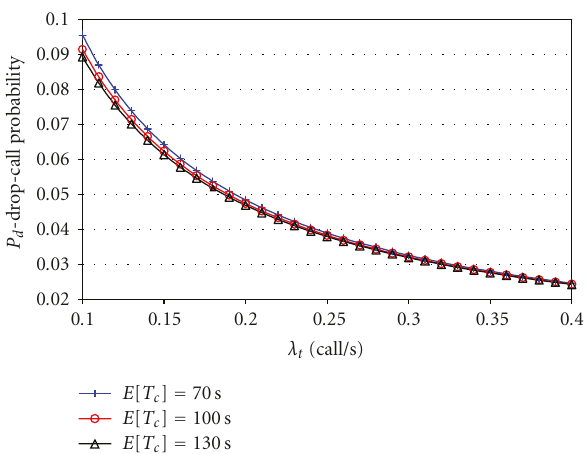
Figure 12: Drop-call probability versus tra ffi c λ t with several coef- ficients of variation C .